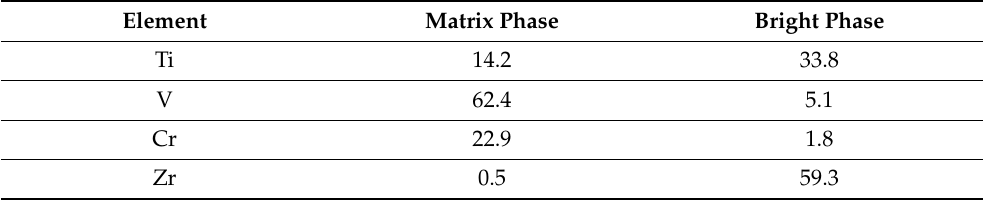
Table 1. EDX analysis showing the elemental composition of phases of Ti 16 V 60 Cr 24 + 4 wt.% Zr alloy.